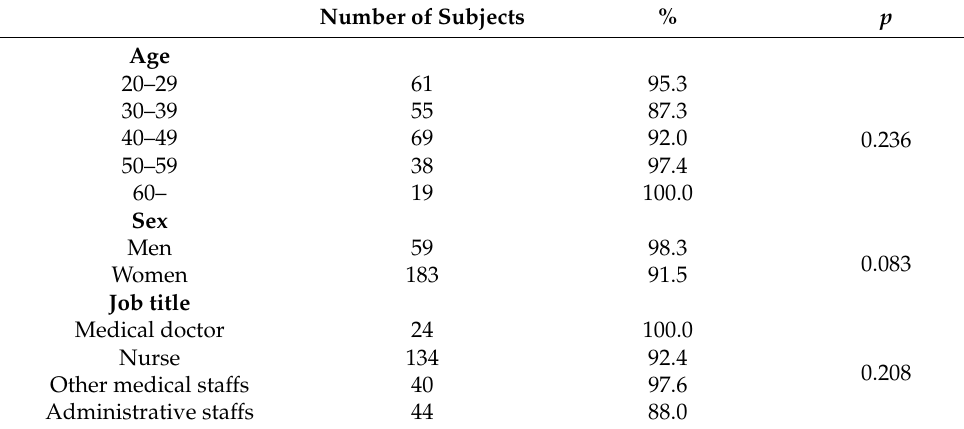
Table 2. Subjects who have agreed to be vaccinated.